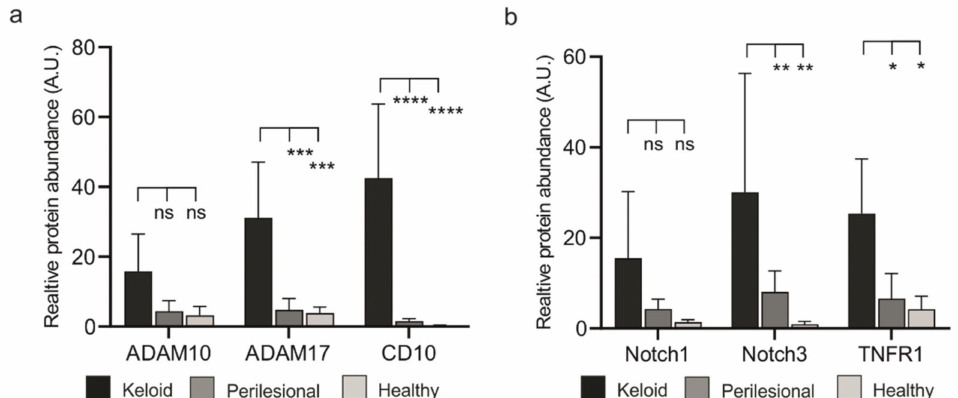
Figure 5. Lesional fibroblasts show elevated expression of proteases and their substrates ( a ) Evaluation of expression of ADAM10, ADAM17 and CD10 in fibroblasts across analyzed keloid and perilesional tissue samples. ( b ) Quantitative analysis of the different substrate of metalloproteases by MAA. Relative expression levels of Notch1, Notch3 and TNFR1 in keloid, perilesional and control tissue. Data are means ± SEM from n patients ( n (Keloid) = 8, n (perilesional) = 6, n (control) = 5). Statistical significance was assessed based on the p value (ns p > 0.5, * p < 0.05, ** p < 0.01, *** p < 0.001, **** p < 0.0001) and determined using two-way ANOVA and Tukey’s